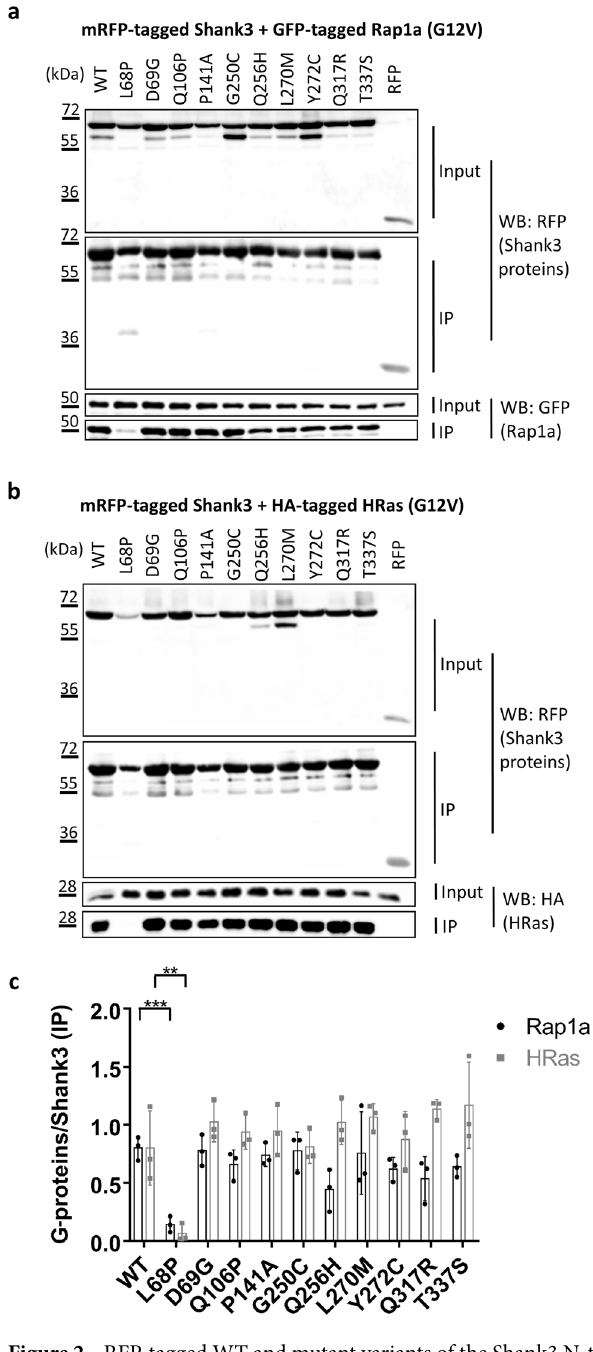
Figure 2. RFP-tagged WT and mutant variants of the Shank3 N-terminus (SPN + Ank domains), or mRFP alone, were coexpressed in 293 T cells with active (G12V-mutant) variants of the small G-proteins Rap1a (GFP-tagged; a ) or HRas (HA-tagged, b ). After cell lysis, RFP-tagged proteins were immunoprecipitated using the mRFP-trap matrix. Input and precipitate samples were analysed by Western blotting using epitope-specific antibodies. ( c ) Quantitative analysis of the data shown in ( a ) and ( b ). Signal intensities in IP samples for G-proteins were divided by IP signals for mRFP-Shank3 variants. ** , ***Significantly different from WT, p < 0.01, p < 0.001; data from three independent experiments; ANOVA, followed by Dunnett’s multiple comparisons